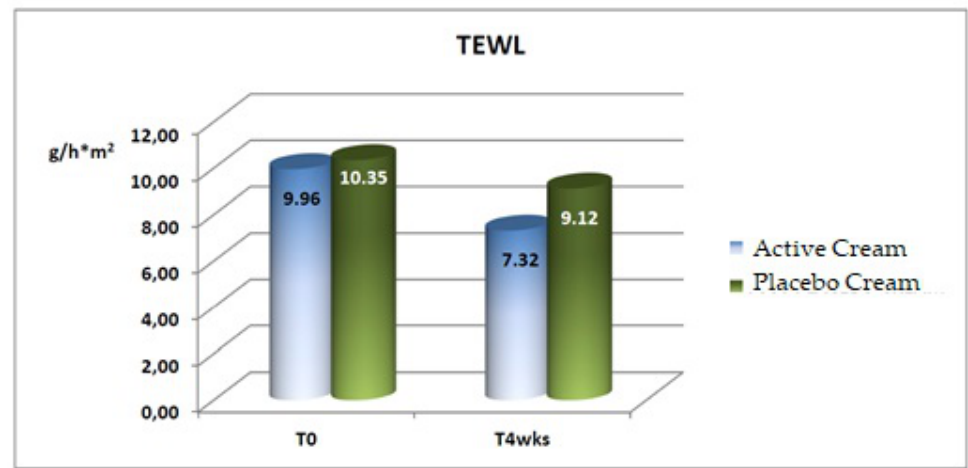
Figure 4. Mean values of TEWL recorded for active cream and placebo product.